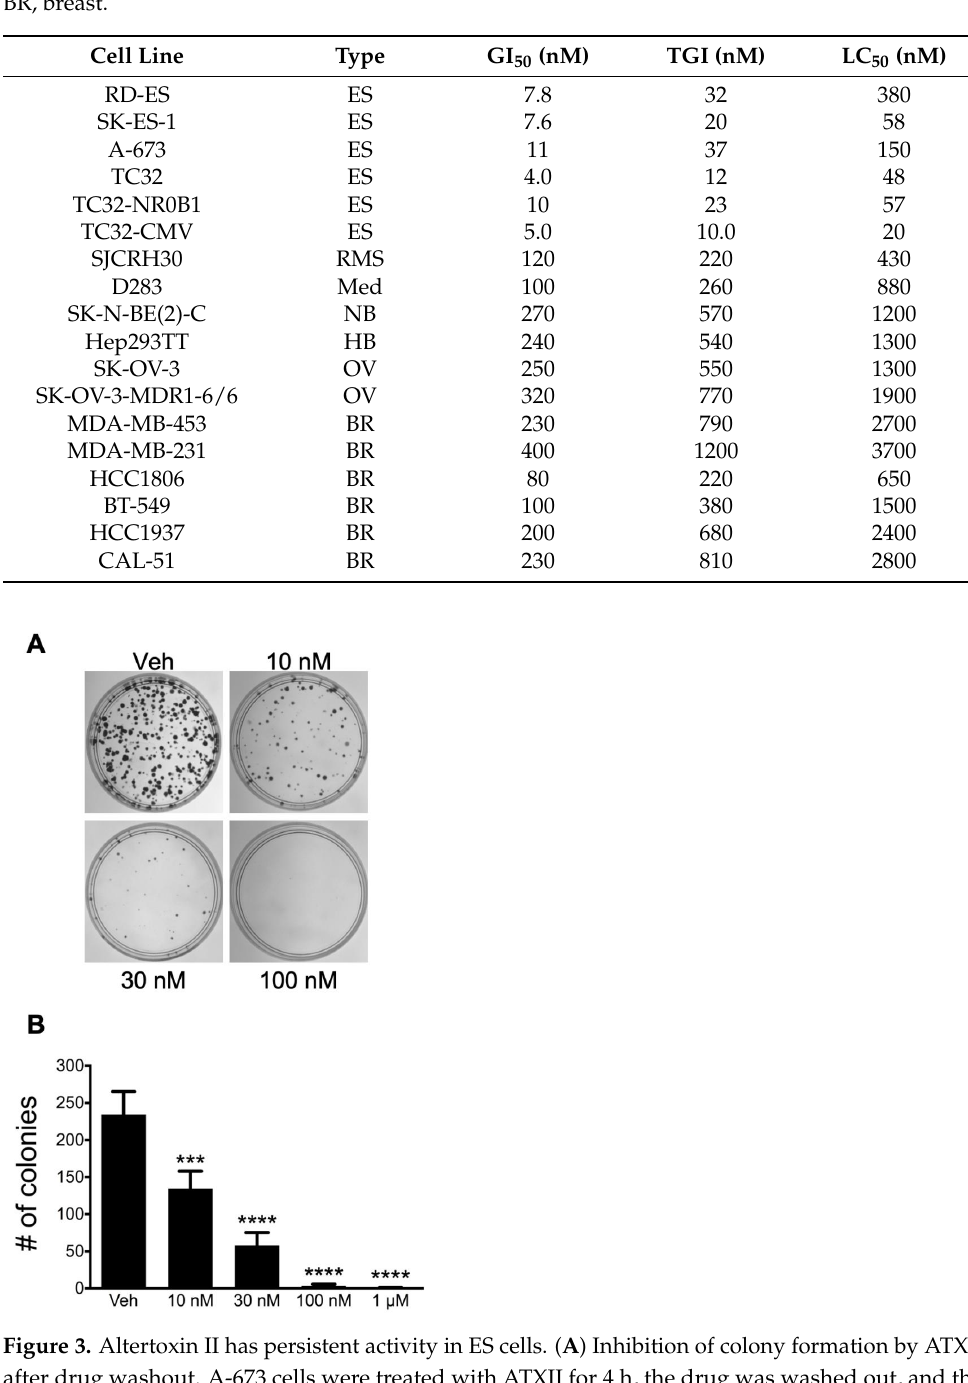
Table 1. Sulforhodamine B assay potency measurements for ATXII. ES, Ewing sarcoma; RMS, rhabdomyosarcoma; Med, medulloblastoma; NB, neuroblastoma; HB, hepatoblastoma; OV, ovarian, BR, breast. Cell Line Type GI 50 (nM) TGI (nM)